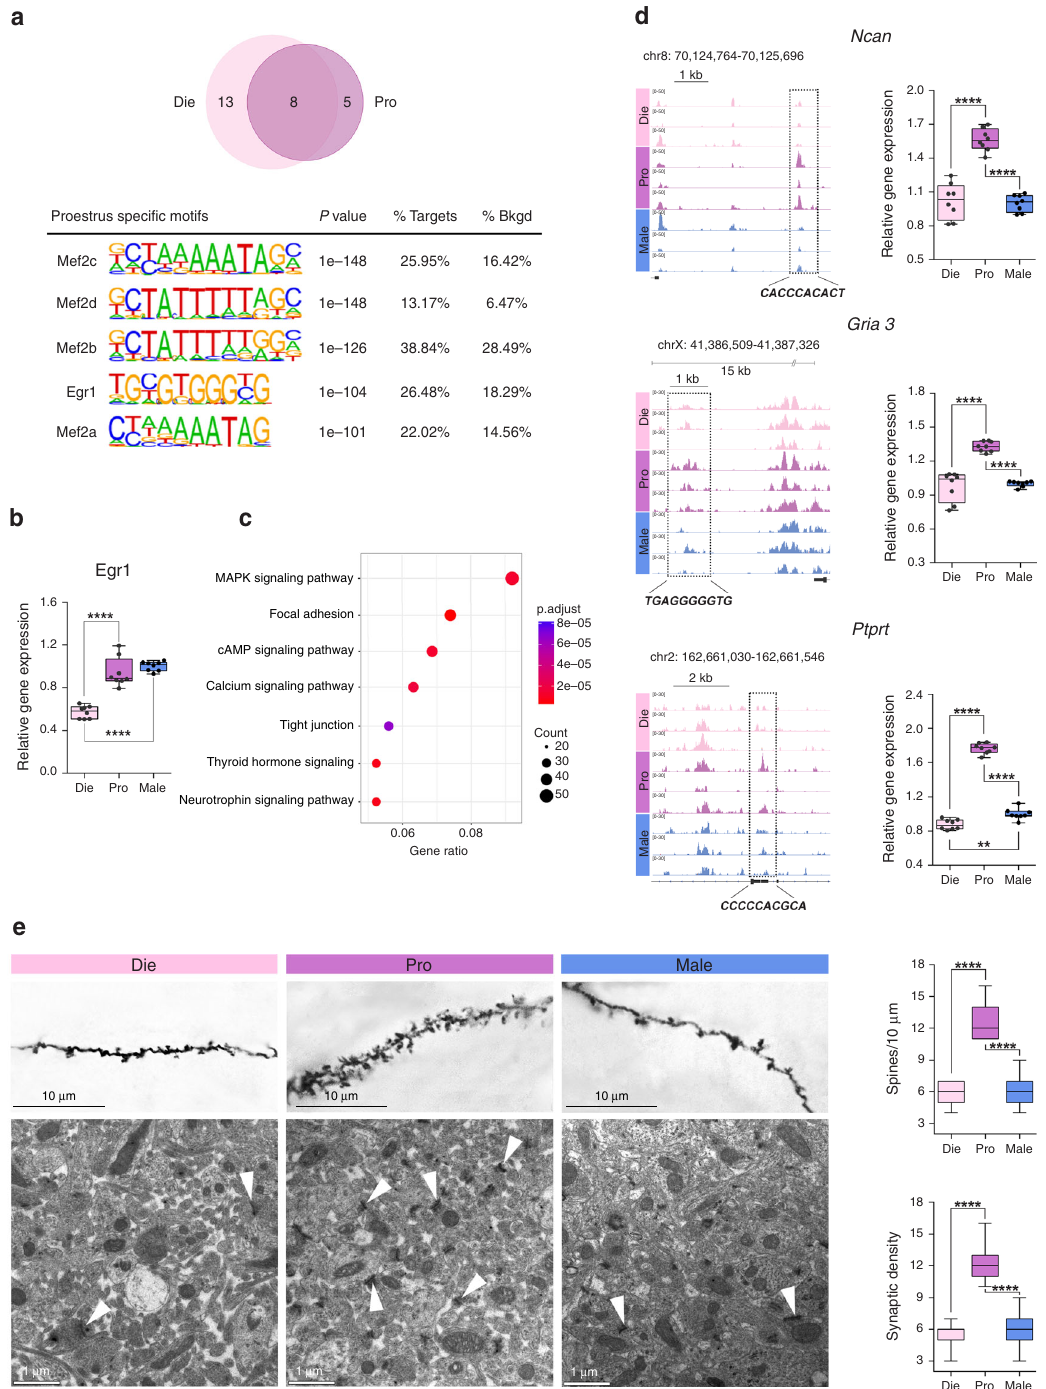
Fig. 3 Egr1 motif-containing genes show chromatin reorganization and are implicated in the oestrous cycle- and sex-dependent synaptic plasticity. a Motif analysis of genomic sequences showing differential chromatin accessibility between dioestrus and proestrus identi fi ed fi ve binding motifs as being overrepresented among the regions open in proestrus and closed in dioestrus ( n = 3 biological replicates/group). b Egr1 mRNA levels in the ventral hippocampus of proestrus, dioestrus and males ( n = 8 animals/group). c Top KEGG pathways enriched in Egr1 motif-containing, proestrus-speci fi c peaks. d Chromatin accessibility pro fi les of the putative regulatory regions of Ncan , Gria3 and Ptprt ( n = 3 biological replicates/group) and the corresponding mRNA levels ( n = 8 animals/group). Shown are the genomic coordinates of the differential ATAC-seq peaks, their relative distance to the TSS, and a predicted Egr1 binding sequence within each peak. e Dendritic spine (Golgi staining, n = 5 animals/group; scale bar: 10 μ m) and synaptic (electron microscopy, n = 3 animals/group, scale bar: 1 μ m) density in the ventral hippocampus of dioestrus females, proestrus females, and males, and their quanti fi cation. Box plots (box, 1st – 3rd quartile; horizontal line, median; whiskers, min/max); ** p < 0.01; **** p < 0.0001 (one-way ANOVA with the Tukey ’ s post hoc test). Die (light pink), dioestrus; Pro (purple), proestrus; Male (blue),